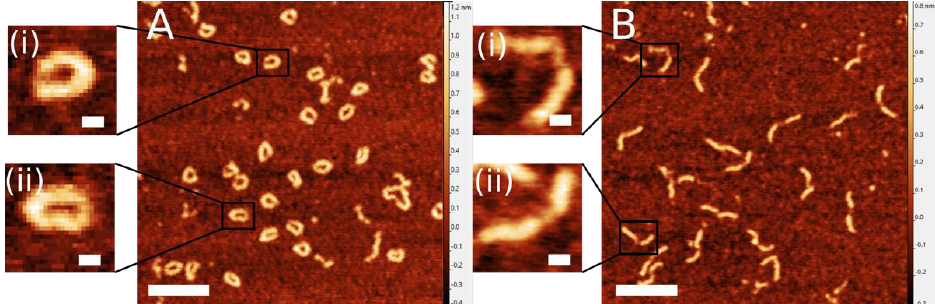
Figure 2. Representative images of nanoring complexes ( A ) and gap DNA constructs ( B ) with zoomed-in examples ( i,ii ) imaged in air. Scale bars indicate 100 nm in large-scale images and 10 nm in zoomed-in images.